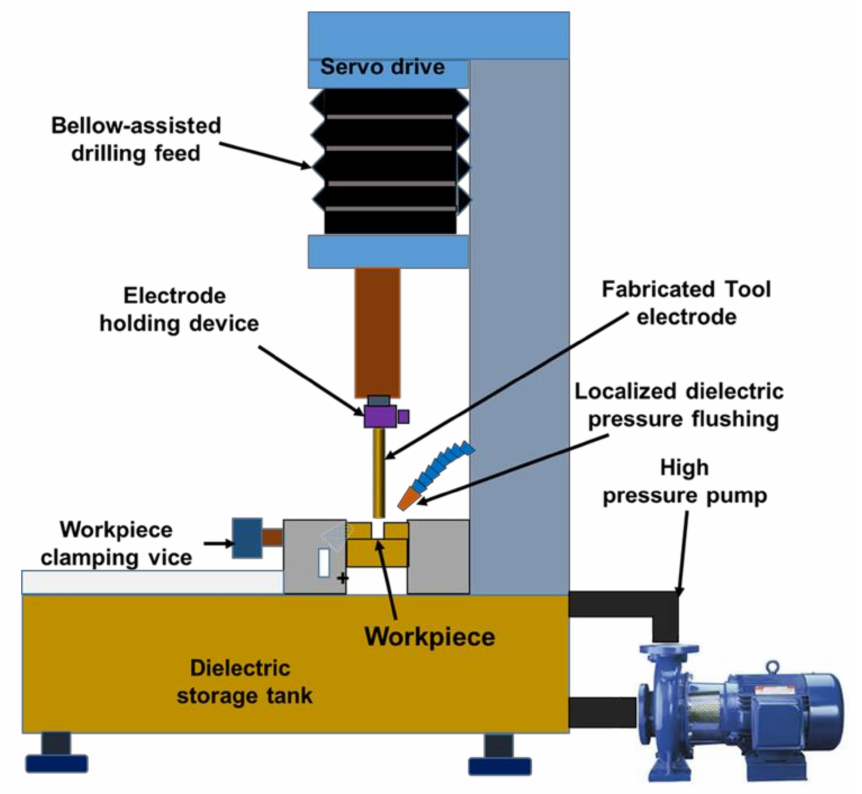
Figure 1. Schematic representation of micro-spark-erosion machining ( µ -SEM) setup for